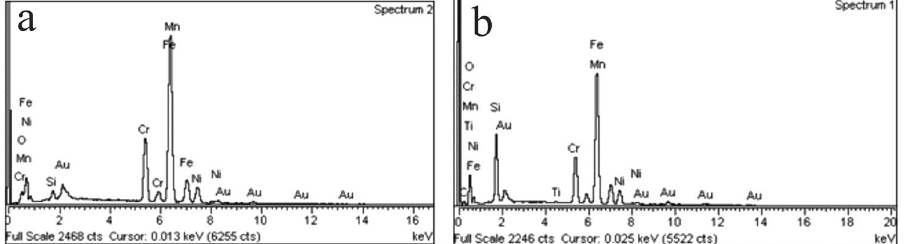
Figure 6. EDS spectrum of the SS polished ( a ) and SS-TiO 2 coated ( b ) surfaces.